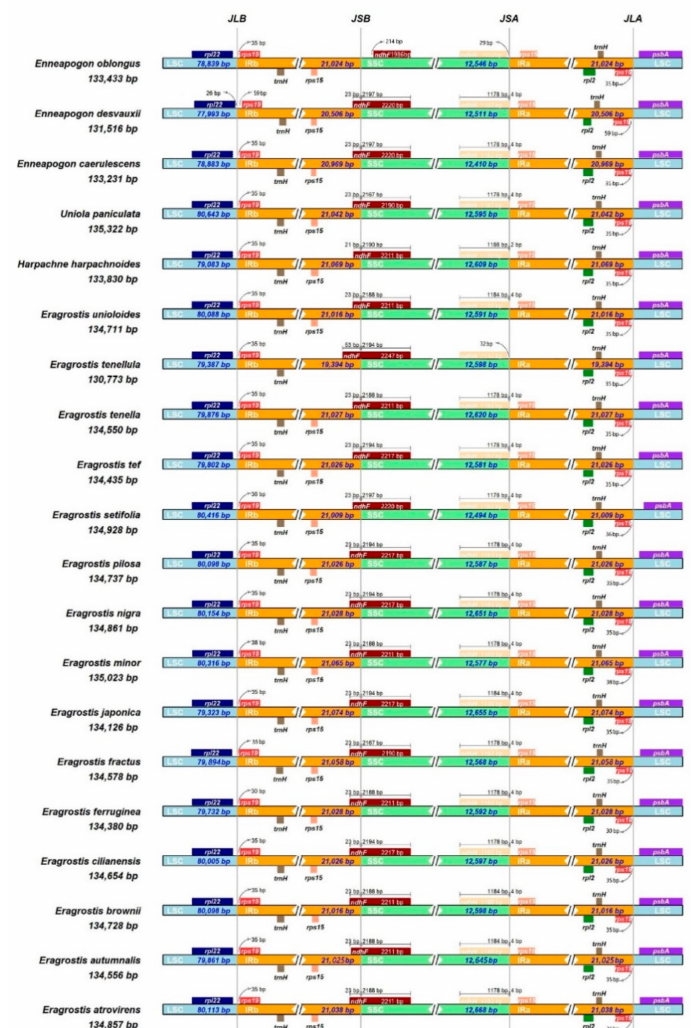
Figure 5. Comparison of the junctions of LSC, SSC, and IR regions among 20 Eragrostideae chloroplast